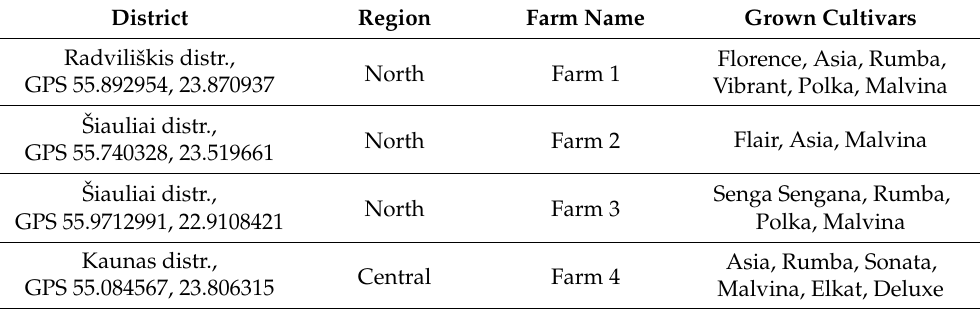
Table 1. The iMETOS ® meteorological station locations in Lithuania and strawberry